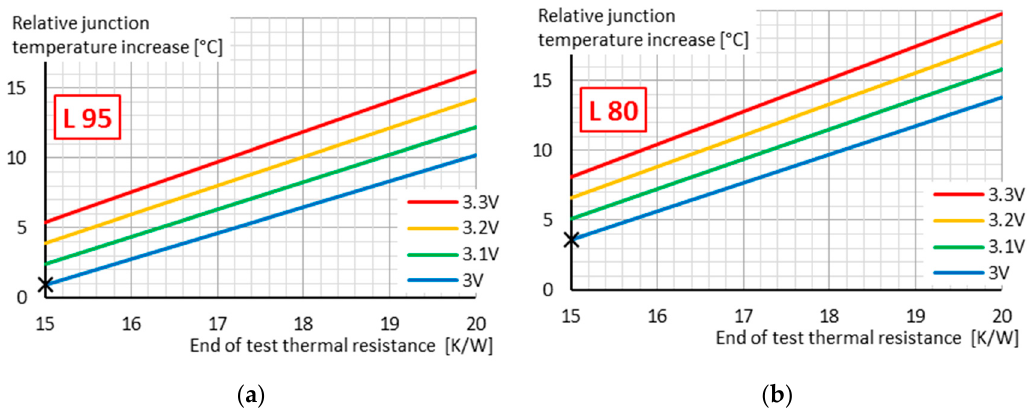
Figure 3. Effects of the increase in the forward voltage and in the thermal resistance on the pn-junction temperature increase during an LM-80 test. The initial parameters are: 1 A forward current, 40% radiant efficiency, 15 K/W thermal resistance, 3 V forward voltage. The figures show the junction temperature increase during the test as the function of the end of test thermal resistance and forward voltage. The end of test relative light outputs are ( a ) 95% and ( b ) 80%. The black crosses indicate values corresponding to that of in Figure 2a.